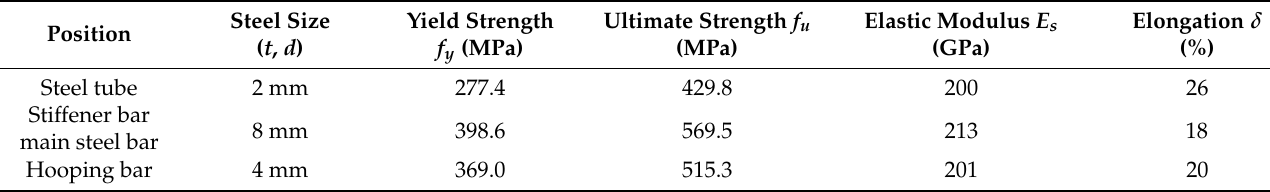
Table 2. The properties of the steel material.